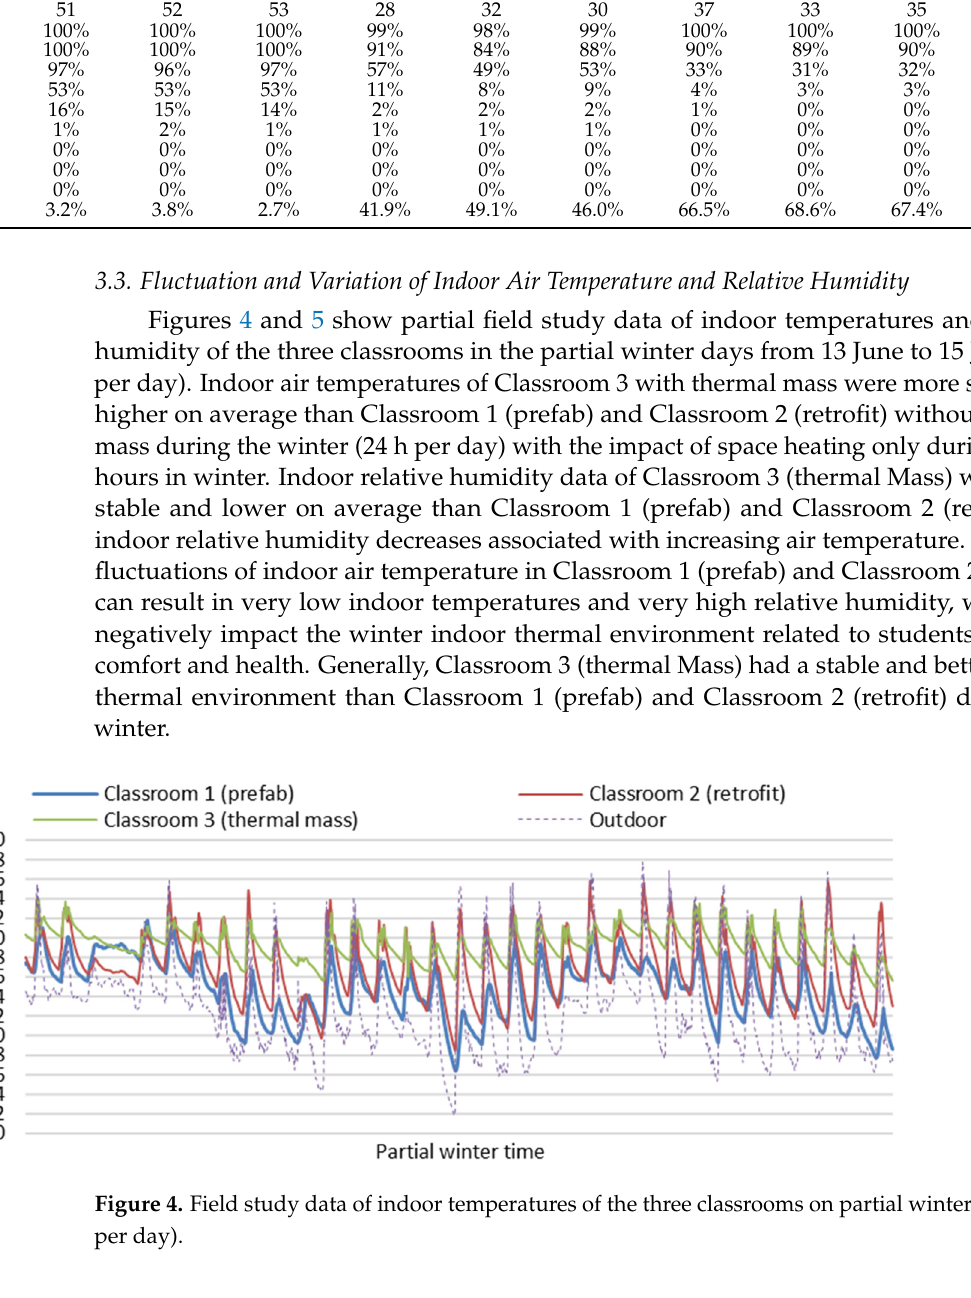
Figure 5. Field study data of indoor relative humidity of the three classrooms on partial winter days (24 h per day). Figures 6 and 7 show partial field study data of indoor temperatures and relative humidity of the three classrooms during school hours (8:30 a.m. to 3:30 p.m.) on the partial winter days from 13 June to 15 July. As the field study data of indoor temperatures of the three classrooms were mainly impacted and controlled by the space heating during the school hours, it is hard to use this field study to identify the impacts of different building envelopes on the indoor thermal environment, and it is difficult to tell the difference in indoor temperature and relative humidity between the classrooms, especially for Classroom 2 and Classroom 3 with or without thermal mass.